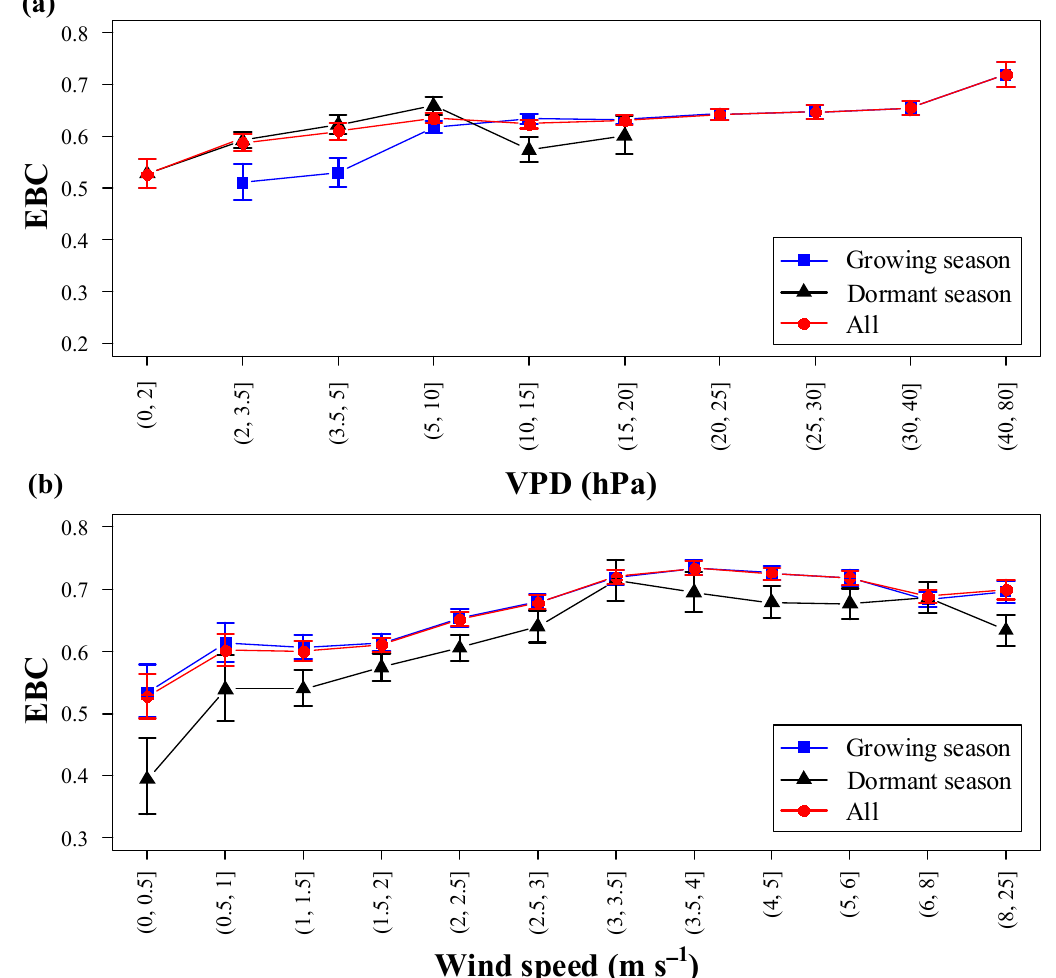
Figure 14. Average EBC for each bin of ( a ) vapor pressure deficit (VPD), and ( b ) wind speed. For certain VPD bins, insufficient data were available for either the growing or dormant season, so EBC values for that season were omitted.